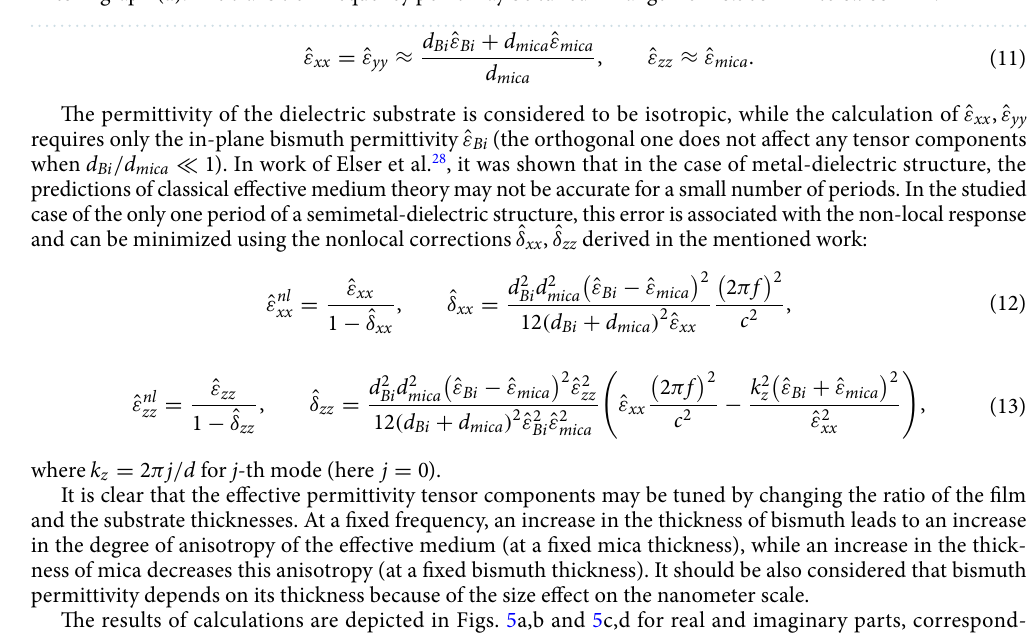
Figure 5. Results of experiment (permittivity tensor). Real ( a,b ) and imaginary ( c,d ) parts of permittivity tensor components of the whole Bi-on-mica structure in the cases of 40 ( a,c ) and 120 ( b,d ) nm bismuth films and for various power of optical pumping. The topological transition region is highlighted by vertical dashed lines in graph ( a ). The transition frequency point may be tuned in range from 0.560 THz to 0.708